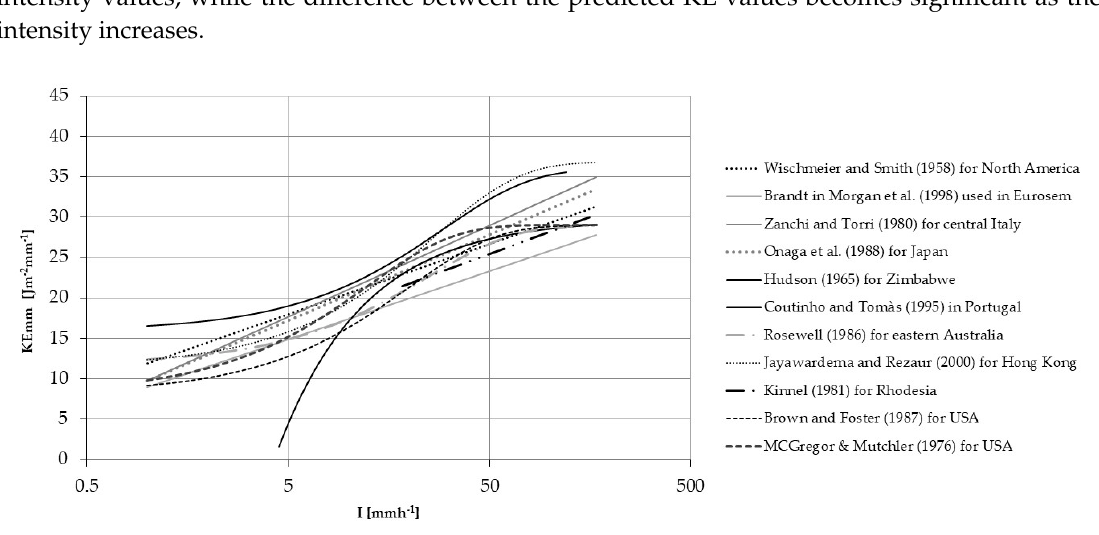
Figure 5. Kinetic-energy–rainfall-intensity (KE mm –I) relationships developed for different pluviometric regimes across the world (after Salles et al. [9]).